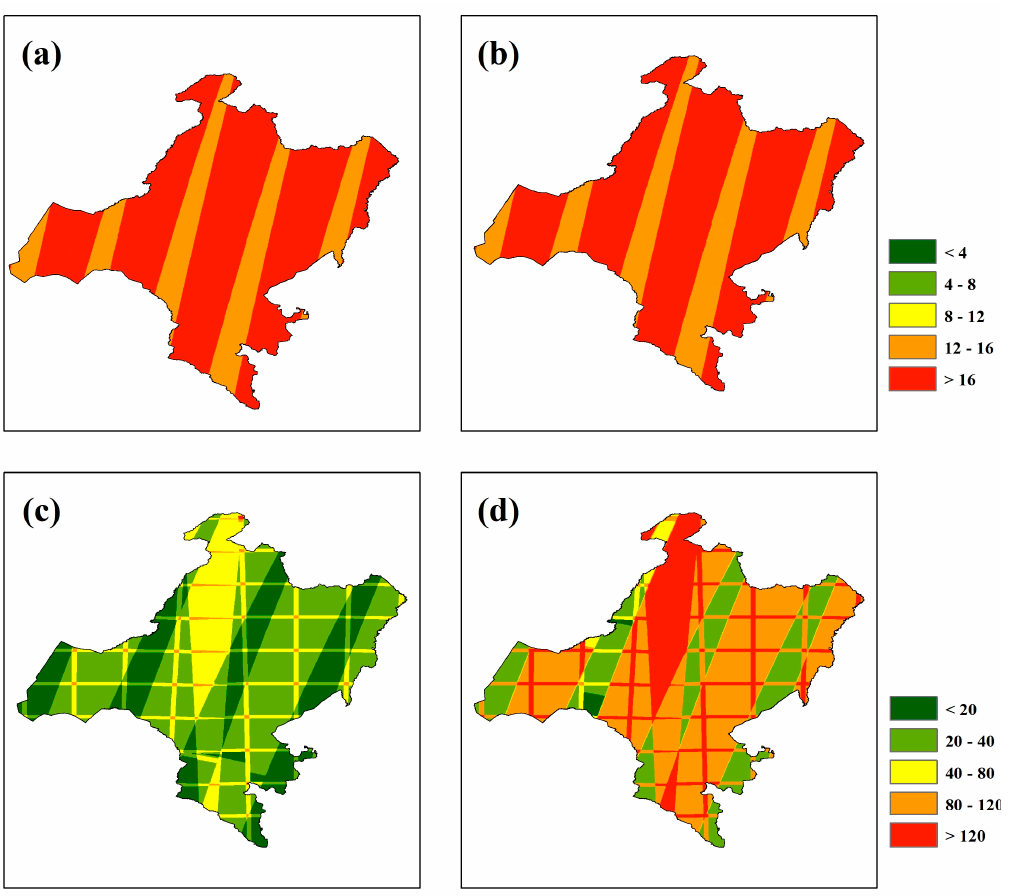
Figure 3. The Sentinel-1 frequency over study area from April to October in ( a ) 2017 and ( b ) 2018, the Sentinel-2 frequency in the same season of ( c ) 2017 and ( d ) 2018.